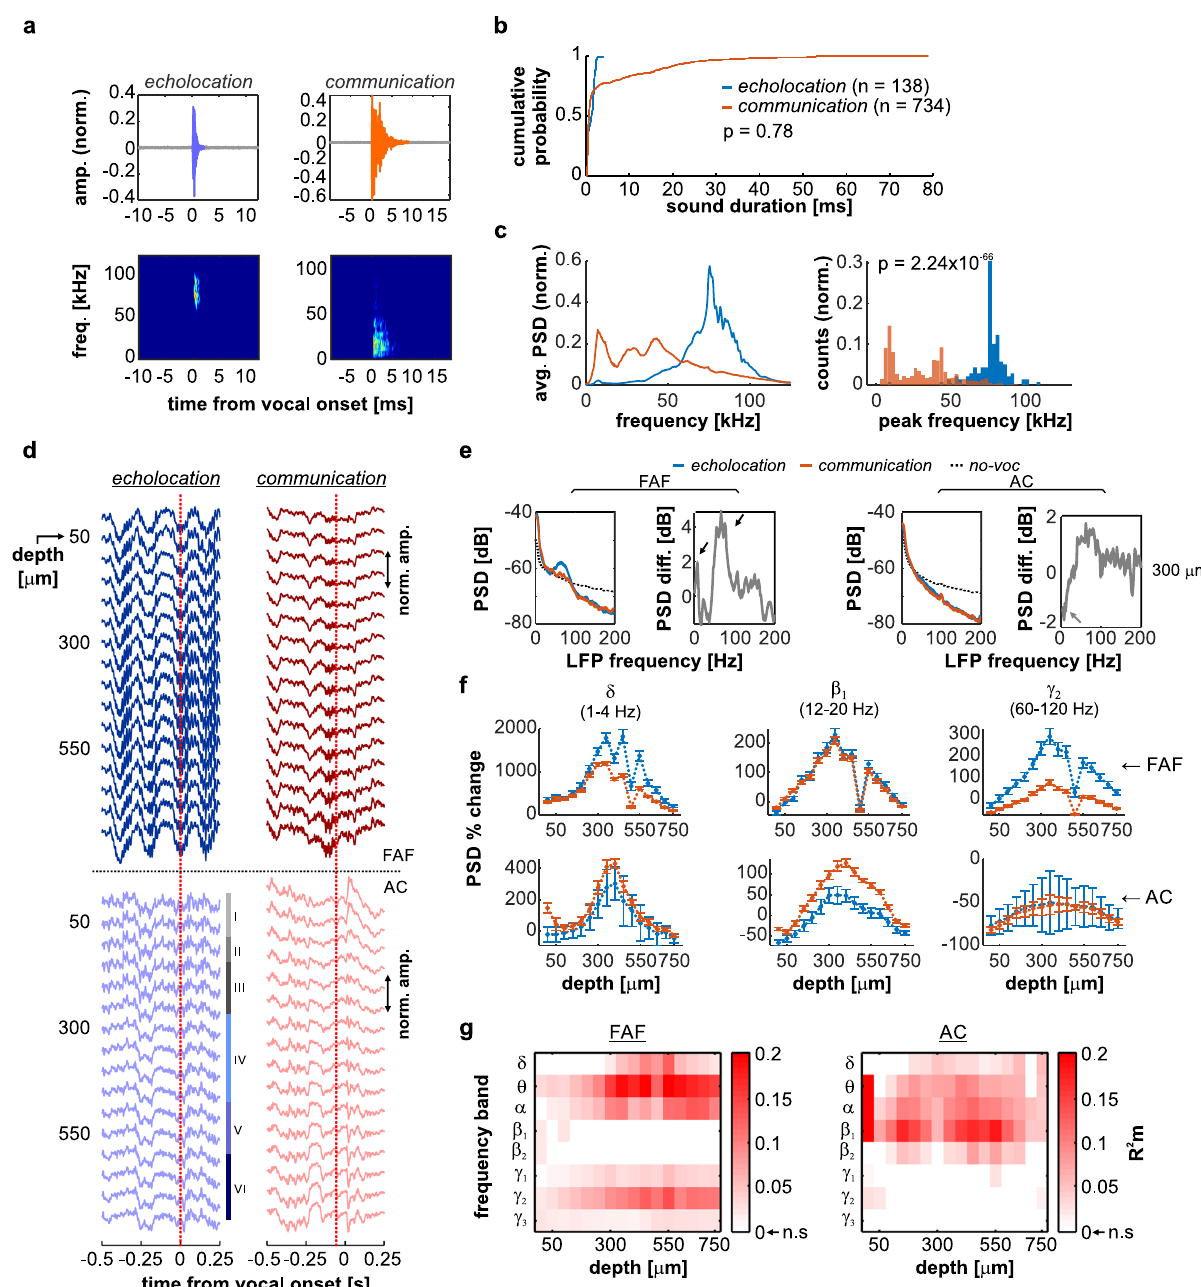
Fig. 1 Pre-vocal oscillations in frontal and auditory cortices predict ensuing vocal output. a Oscillograms (top) and spectrograms (bottom) of exemplary echolocation (left) and communication calls produced by C. perspicillata . b Cumulative probability distribution of echolocation (blue, n = 138) and communication (orange, n = 734) call lengths. No signi fi cance differences were observed (two-sided Wilcoxon rank sum test, p = 0.12). c ( Left ) Normalized average power spectral density (PSD) of echolocation (blue) and communication (orange) calls. ( Right ) Distribution of peak frequencies of echolocation and communication utterances; communication calls were signi fi cantly higher in frequency than their counterparts (two-sided Wilcoxon rank sum rest, p = 2.24 × 10 − 66 ). d Single-trial LFPs recorded simultaneous to echolocation and communication utterances. The vertical red dashed line, at time 0, indicates the moment of vocalization onset. The top 16 traces correspond to LFPs recorded in the FAF; the bottom 16 LFP traces were recorded from the AC. Auditory cortical layers are marked. LFP amplitude was normalized within structure independently. e Average pre-vocal ( − 500 to 0 ms, relative to call onset) power spectral densities (PSD) at a representative depth (300 μ m) in FAF and AC. Blue: echolocation; orange: communication; black, dashed: no- voc periods. The difference between echolocation and communication PSDs is depicted in gray (right). f Percentage pre-vocal power change across representative LFP bands ( δ , 1 – 4 Hz; β 1 , 12 – 20 Hz; γ 2 , 60 – 120 Hz), relative to a no-voc baseline, across cortical depths in FAF (top) and AC (bottom). Values related to echolocation utterances ( n = 138) are depicted in blue; those related to communication utterances ( n = 734) are depicted in orange. Data shown as mean ± sem. g Pre-vocal power change in frontal and auditory regions predict vocalization type. Effect size ( R 2 m ) of GLMs considering all frequency bands and channels, both in frontal and auditory cortices. Effect sizes were considered small when R 2 m < 0.1, and medium for R 2 m > = 0.1. For illustrative purposes, effect size values from non-signi fi cant models were set to 0. Source data are provided as a Source Data fi le.